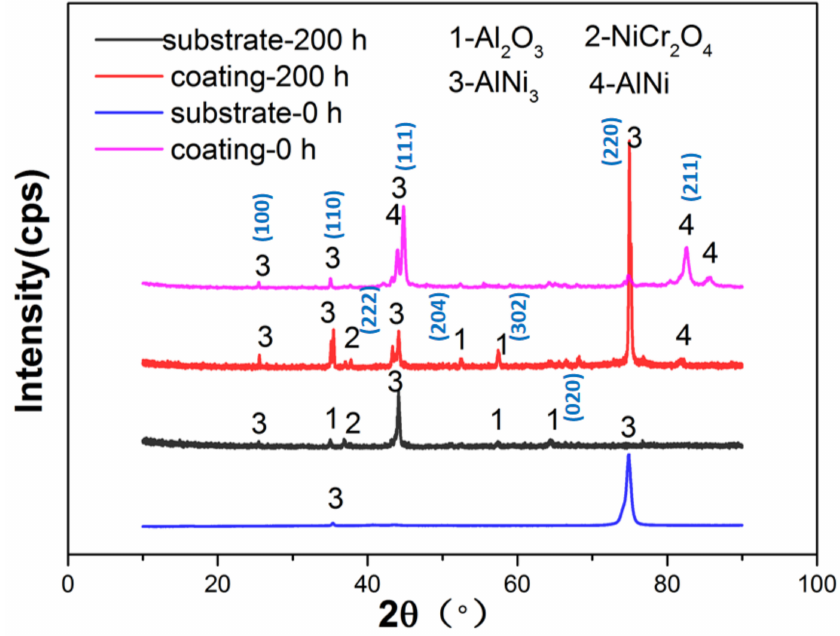
Figure 4. X-ray diffraction patterns of the samples before and after thermal exposure